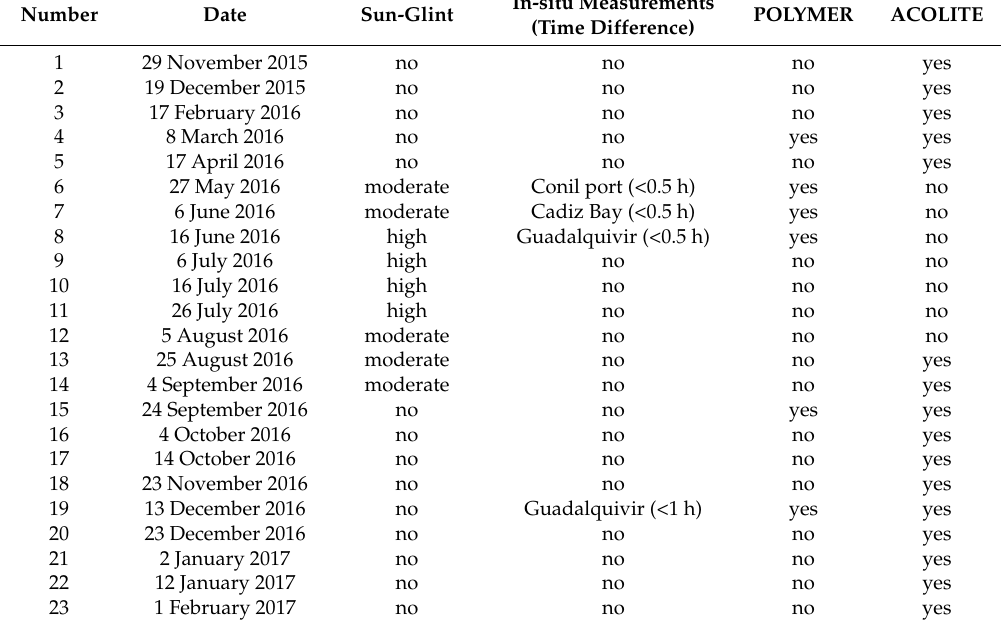
Table 1. List of selected Sentinel-2A images. Only low cloud coverage scenes (<60% cloud coverage) were used in the study. Atmospheric Correction models used for each one are indicated. POLYMER was mainly applied to the scenes where parallel in-situ sampling efforts were accomplished to have sun-glint corrected reflectance for match-ups purposes. No valid data was obtained by ACOLITE in most of the pixels during sun-glint scenes. The time difference is the temporal window between in-situ and satellite